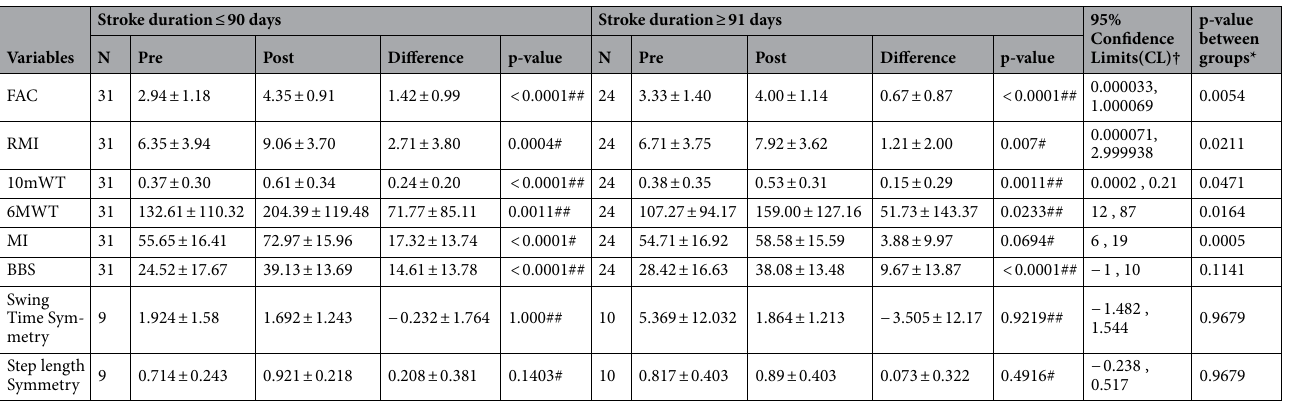
Table 3. The difference of outcome changes with stroke duration in the control group. FAC functional ambulation categories, RMI rivermead mobility index, 10mWT 10-meter walk test, 6MWT 6-minute walk test, MI motricity index, BBS Berg balance scale. # p-value obtained from Paired t-test. ## p-value obtained from Wilcoxon signed rank test. † CL obtained from Wilcoxon’s rank sum test. *p-value obtained from Wilcoxon rank sum test.